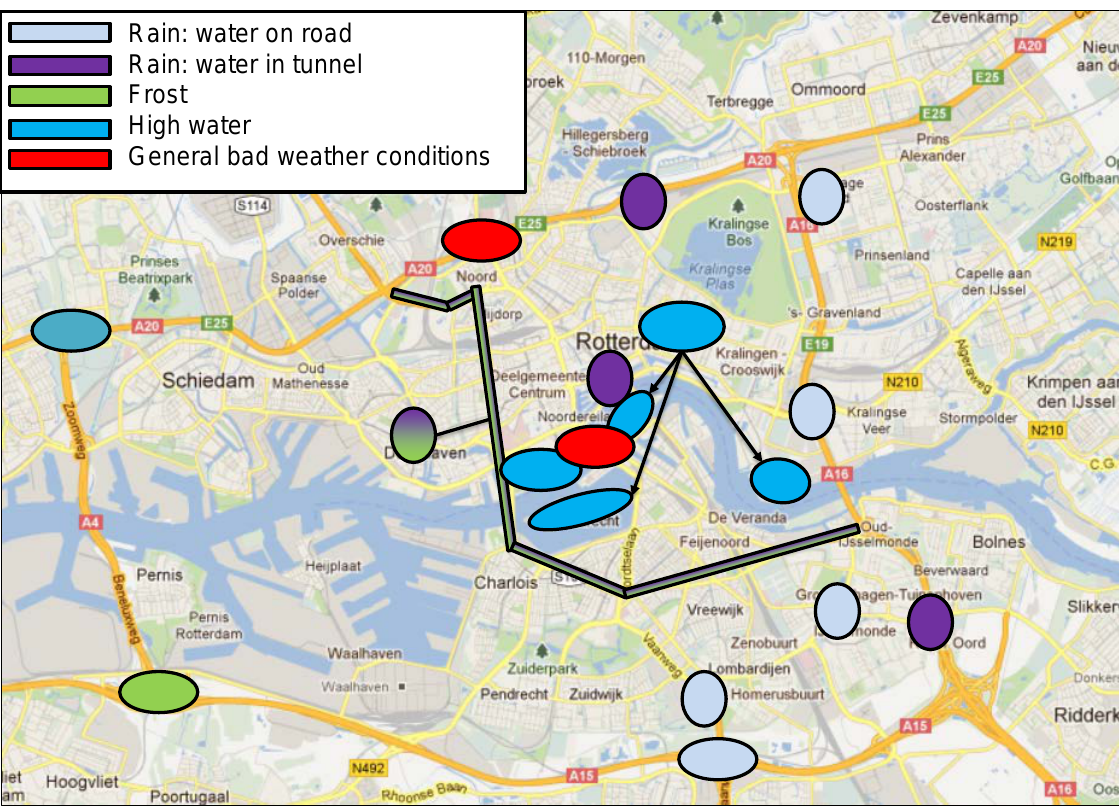
Figure 4. Locations where weather events are likely to cause capacity